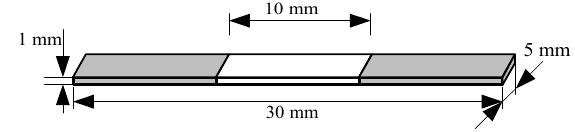
Figure 13. Schematic diagram of the test piece.